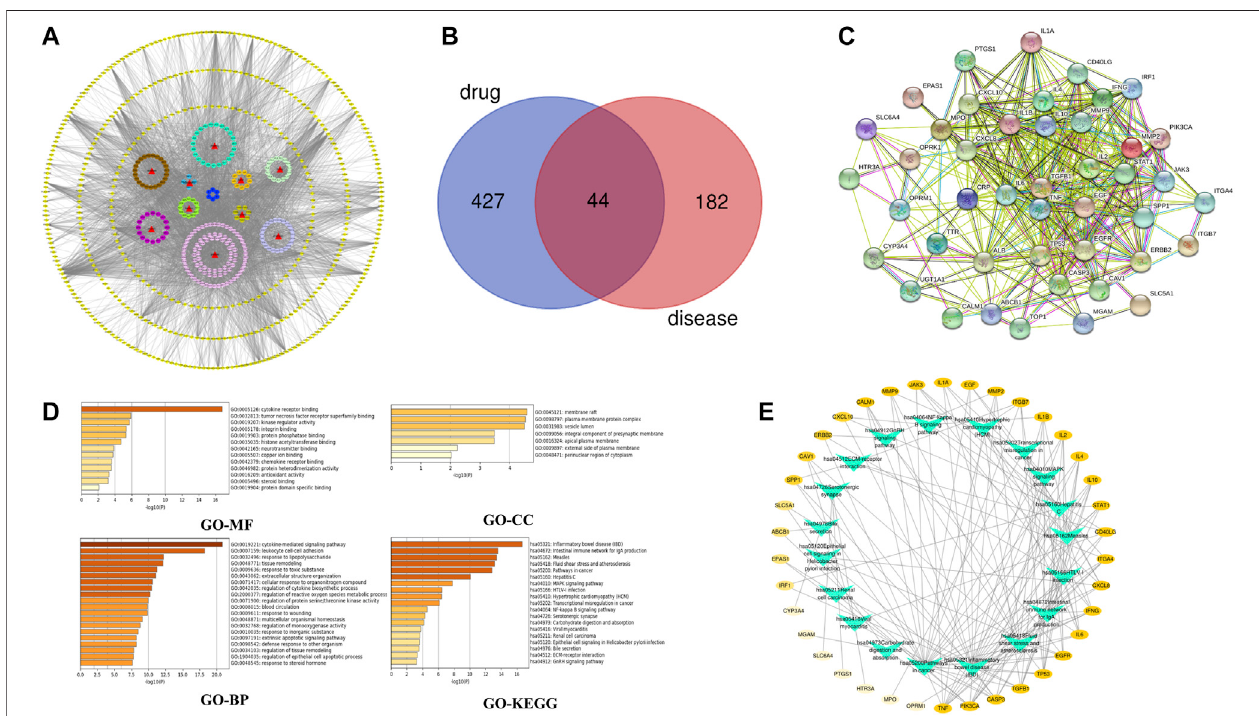
FIGURE2| Networkpharmacologyanalysis (A) Drug-compound-targetnetworkoftheanti-rotaviruseffectofSBP.10herbsareshownasredtriangles,219active compounds are shown as circles with different colors, and 471 target genes are shown as yellow diamonds (B) The common targets of SBP and RVE (C) The PPI network of SBP-RVE (D) GO analysis and KEGG pathway analysis of the common targets of SBP and rotavirus using a bar graph to rank the importance from top to bottom (E) Target-Pathways network. The target genes of SBP-RVE are shown as a yellow oval node. The higher the degree of the target gene, the darker the color. Paths are marked with green triangle